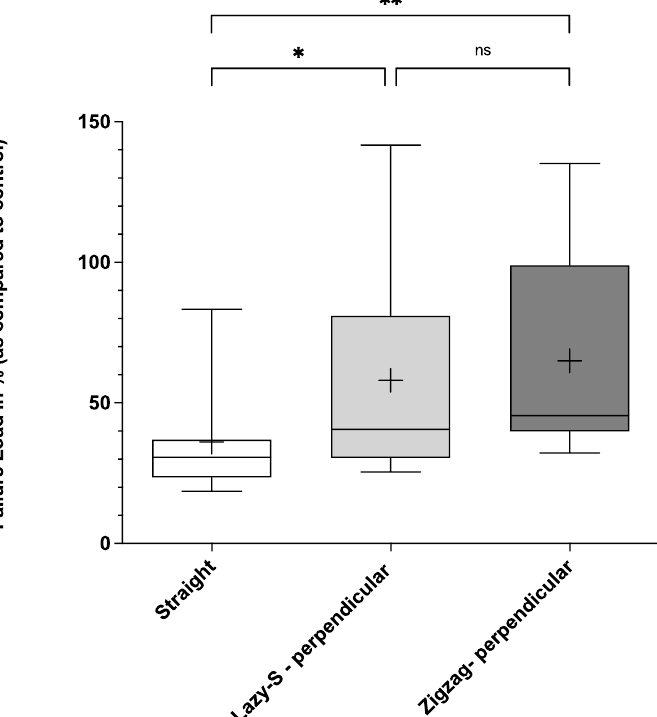
Figure 5 . Third suture failure load (final failure load) for three main incision patterns. Conventional straight, Lazy-S and Zigzag incisions (both with perpendicular (90°) placement of sutures) were tested for their biomechanical stability. The mean is indicated by a cross. The bottom and top of the box are the 25th and 75th percentile. Error bars (whiskers) indicate the 10th and 90th percentile. ** p < 0.01; * p < 0.05; ns , not significant. For each group 17 incision-patterns were tested.